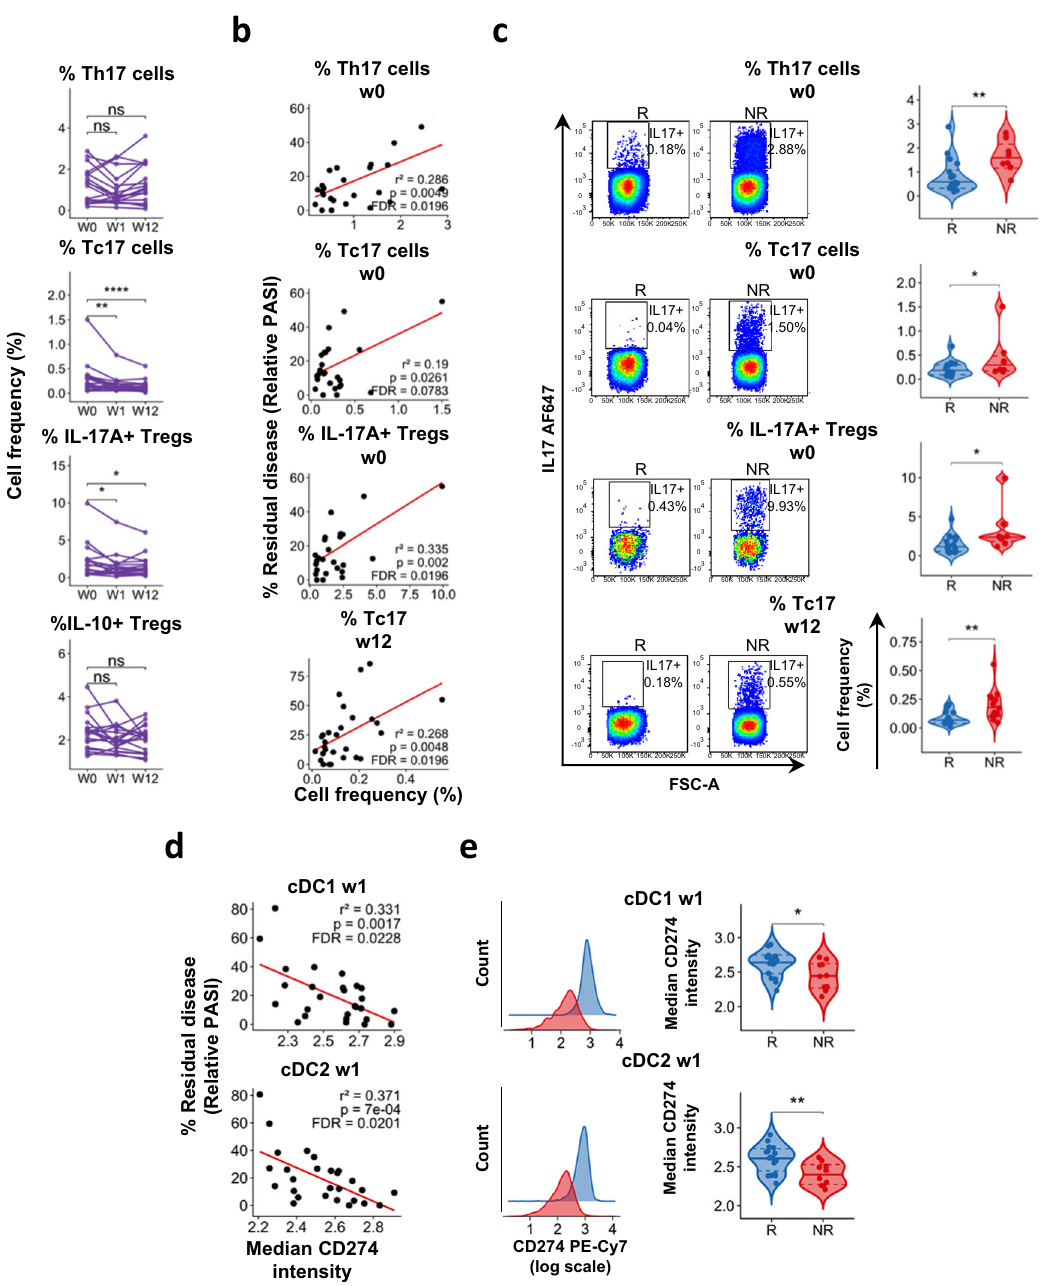
Fig. 4 Response to adalimumab correlates with the frequency of IL17A + T cells and CD274 expression in DC. Immunophenotyping of PBMCs of psoriasis patients at w0 and at w1 and w12 after starting adalimumab therapy. a Frequency of IL10 + and IL17A + CD4, CD8 T cells and Tregs at different time points, each line represents one patient ( n = 19) (p Tc17 W0vsW1 = 0.0014, W0vsW12 = 3.8 × 10 − 6 ; IL17A Tregs W0vsW1 = 0.045, W0vsW12 = 0.018). b Correlation analyses between the frequency of IL17A + or IL10 + cells within CD4, CD8 or Tregs and residual disease at w12 ( n = 26 – 28). c Representative fl ow cytometry colour-plots (left) and violin plots graphs of the frequency of cytokine-producing cells in adalimumab PASI75 responders (R, blue, n week 0 = 18, n week 12 = 15) and non-responders (NR, red, n week 0 = 8, n week 12 = 13) ( p Th17 w0 = 0.0051, Tc17 w0 = 0.047, IL17A Tregs w0 = 0.011, Tc17 w12 = 0.0037). d Correlation analyses between the expression of CD274 at w1 and residual disease at w12 in cDC1 and cDC2 ( n = 27). e Representative histograms overlay graphs (left) and violin plots graphs (right) of CD274 expression in DC of PASI75 adalimumab responders (blue, n = 17) and non-responders (red, n = 10) * p = 0.045, ** p = 0.0058. Kruskal – Wallis with Dunn ’ s multiple comparisons post-test ( a ), Mann – Whitney U test ( c ) or unpaired t test ( e ). All tests are two-sided. Source data are provided as a Source Data fi to healthy volunteers (Supplementary Fig. 10). Tc17 and IL-17A + frequency of Th17 and IL-17A + Treg at w0 and of Tc17 at w12 Treg cells signi fi cantly decreased during adalimumab therapy, (Fig. 4b and Supplementary Data 8). In keeping with this fi nding, while frequency of Th17 and IL10 + Treg cells did not change PASI75 non-responders had signi fi cantly higher frequency of Th17 and IL-17A + Treg at w0 and Tc17 at week 12 (Fig. 4c). (Fig. 4a). Moreover, we detected a statistically signi fi cant Moreover, the frequency of Th17 and IL-17A + Tregs cells was correlation (liner regression) between residual disease and the